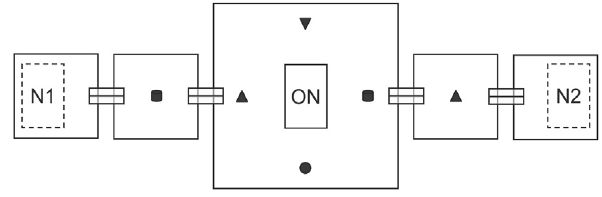
Figure 1. Experimental design. Top view of the exploration arena consisting of one large, central dish; two small, intermediate dishes; and two small, peripheral dishes. Adjacent dishes were connected by tunnels for the ants to walk through. Conspicuous landmarks (black shapes) were used to help ants orientate inside the arena. Colonies housed in their old nest (ON) were positioned in the middle of the central dish. One or two available new nest sites (N1 and N2) were positioned in the peripheral dishes either at the onset of exploration (familiar nests) or at the onset of emigration (unfamiliar nests). The position of new nest sites (right or left) was pseudo-randomized between colonies.